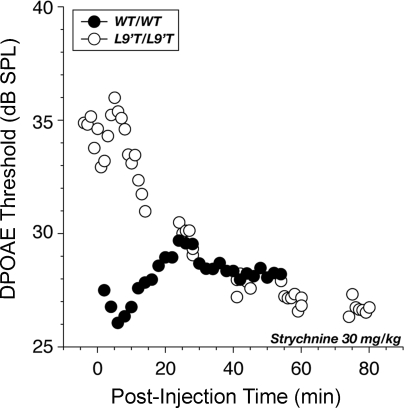
Strychnine Improves Cochlear Thresholds in Mutant MiceBy 1 h postinjection, thresholds in mutant mice recovered to the mean value from wild types (23 dB SPL at 22.6 kHz: Figure 5B). Strychnine produced no systematic effects on wild-type (WT) thresholds. Here, DPOAE thresholds for f2 = 22.6 kHz were repeatedly measured before and after a 30-mg/kg i.p. strychnine injection in a Chrna9wt/wt and a Chrna9L9′T/L9′T. The effect of strychnine was concentration-dependent as shown in Figure S3.